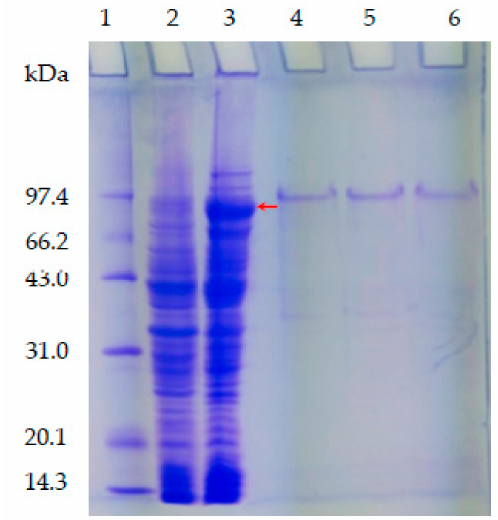
Figure 3. SDS-PAGE analysis of expression and purification of the rPsRNR. Lane 1, protein molecular weight marker; Lane 2, crude extract from the BL21 / pET-28a( + )with IPTG induction; Lane 3, crude extract from the BL21 / pET-28a( + )-rPsRNR; Lane 4–6, the purified rPsRNR protein by Ni-NTA using the bu ff er (pH 8.0) contained 20 mM Tris-HCl, 100 mM NaCl and 50 mM